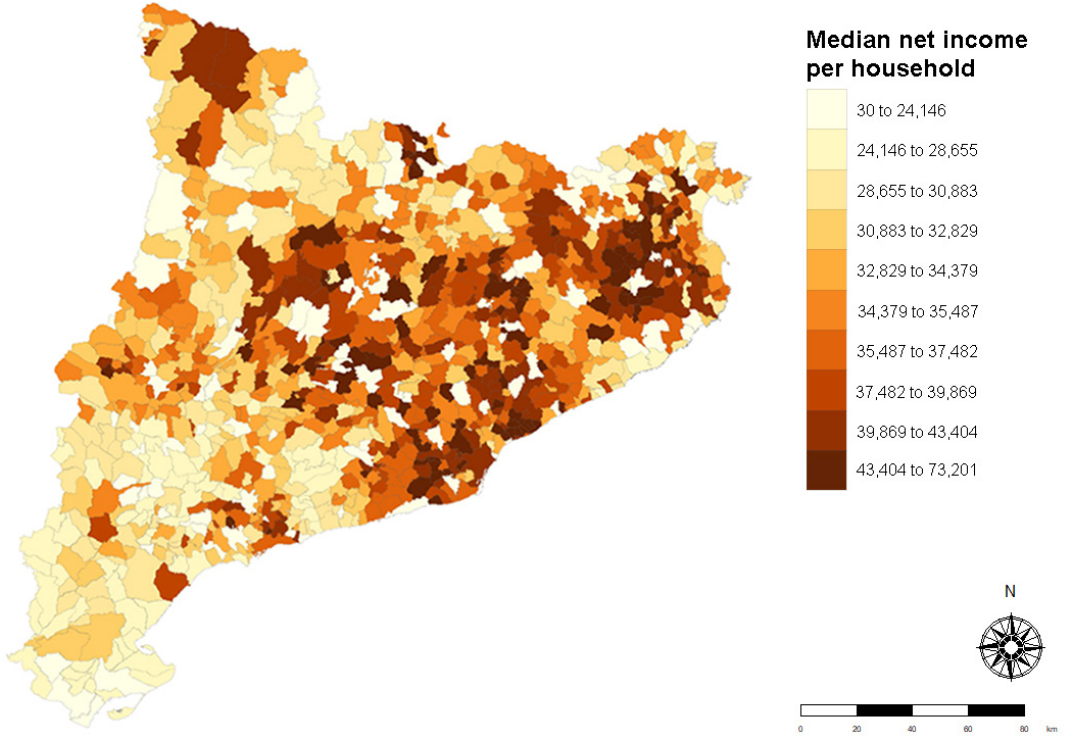
Figure 4. Map of the median net income per household of Catalonia by municipalities.